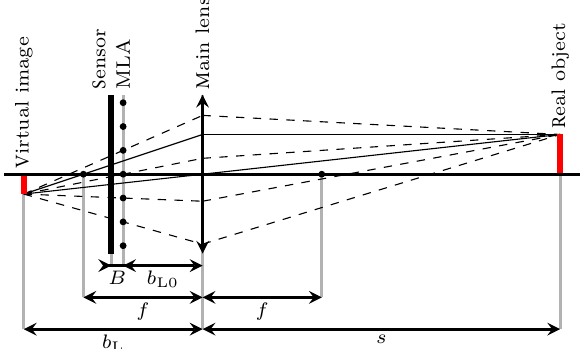
Figure 8. Image projection of a focused plenoptic camera in the Galilean mode. One object point is projected to multiple micro im- ages on the sensor.